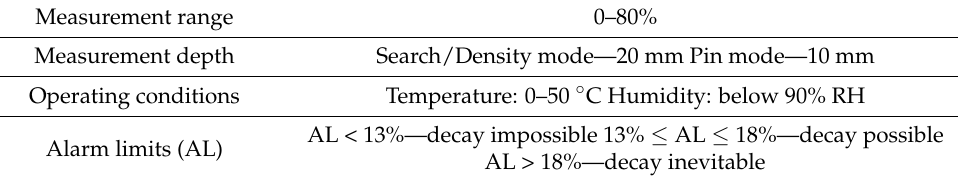
Table 4. SMM specifications